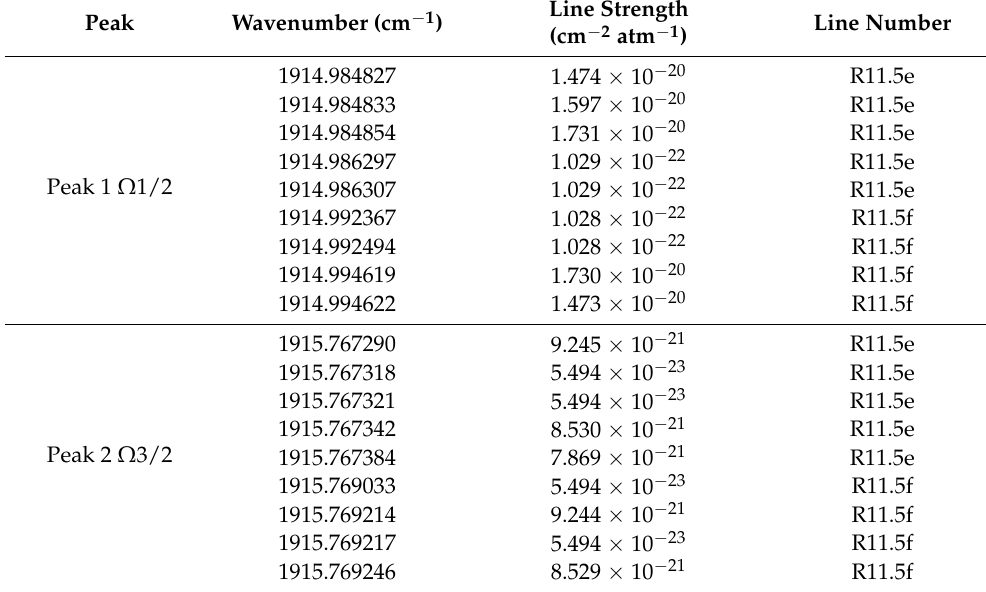
Table 1. The HITRAN database’s line